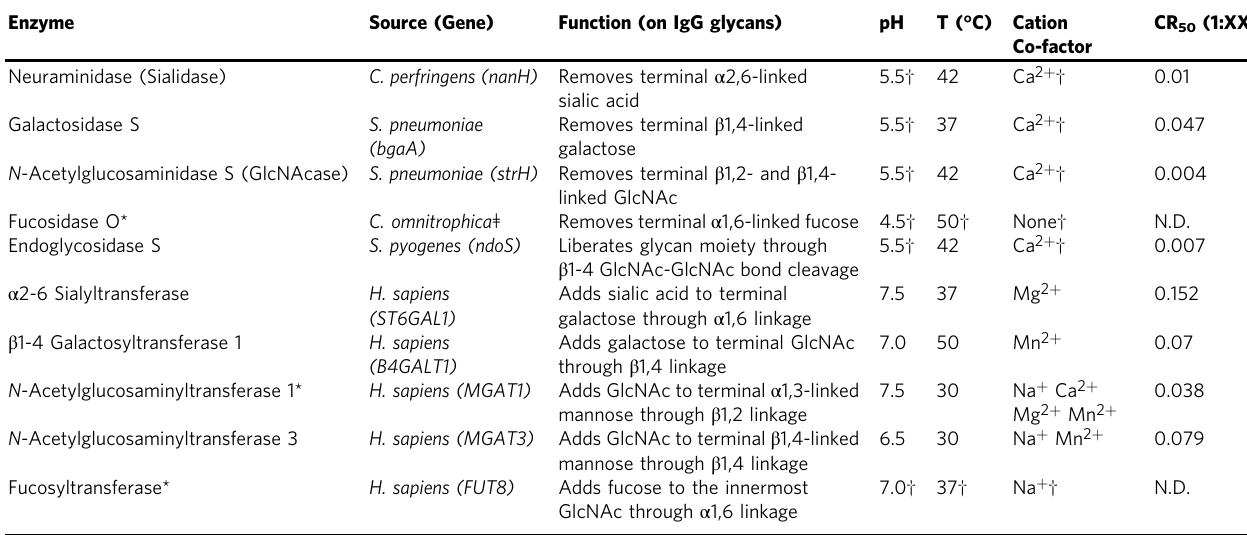
Table 1 Glycoengineering enzymes selected for SPGR and their optimized working conditions.